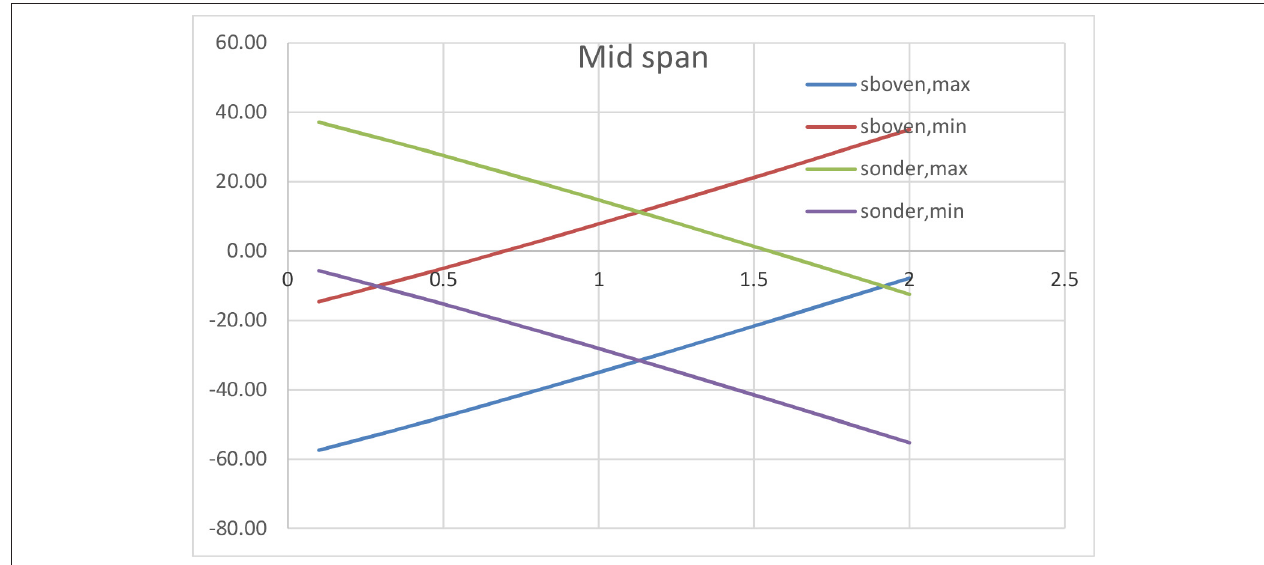
FIGURE 4 | Concrete stresses as a function of deviator’s